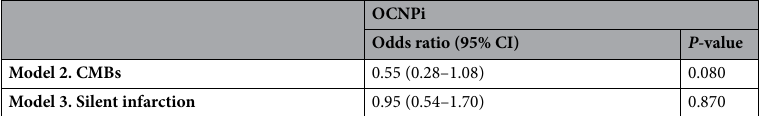
Table 5. Odds ratios of the imaging parameters based on multivariate logistic regression analysis. In Model 2, covariates were age, sex, diagnosis, susceptibility sequence type [susceptibility weighted image (SWI) vs. T2*-weighted gradient echo (GRE)], body mass index (BMI), hypertension, diabetes, ischemic heart disease (IHD), estimated glomerular filtration rate (eGFR), prior use of antithrombotics, and dyslipidemia. In Model 3, covariates were age, sex, diagnosis, MRI field strength (3 T vs. 1.5 T), BMI, hypertension, diabetes, IHD, eGFR, prior use of antithrombotics, and dyslipidemia. OCNPi ocular cranial nerve palsy of presumed ischemic origin, CMBs cerebral microbleeds, CI confidence interval.